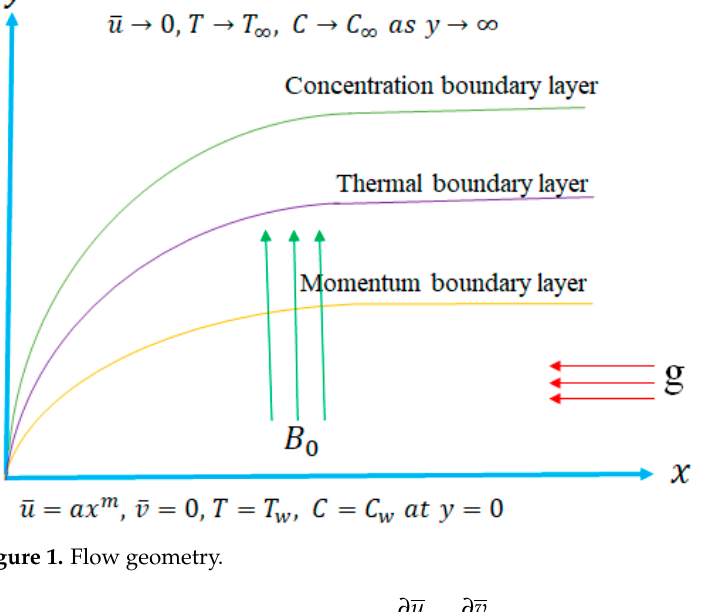
Figure 1. Flow geometry.